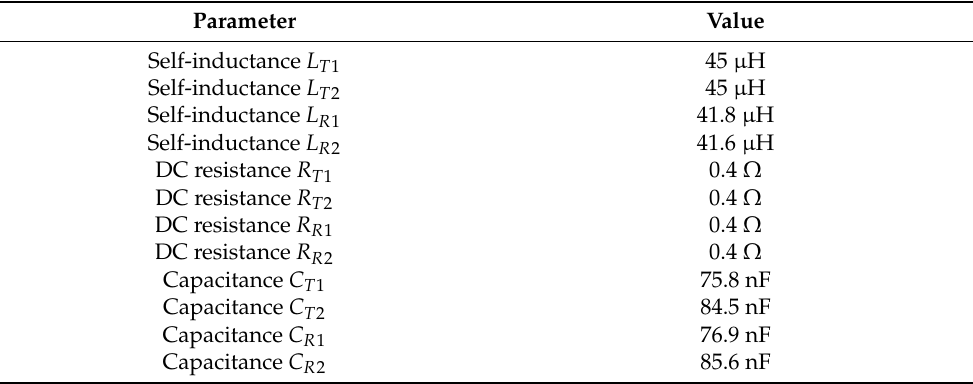
Table 1. IPT system parameters.